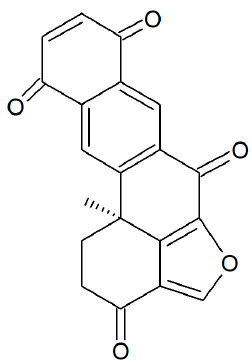
Figure 19. Structure of halenaquinone.